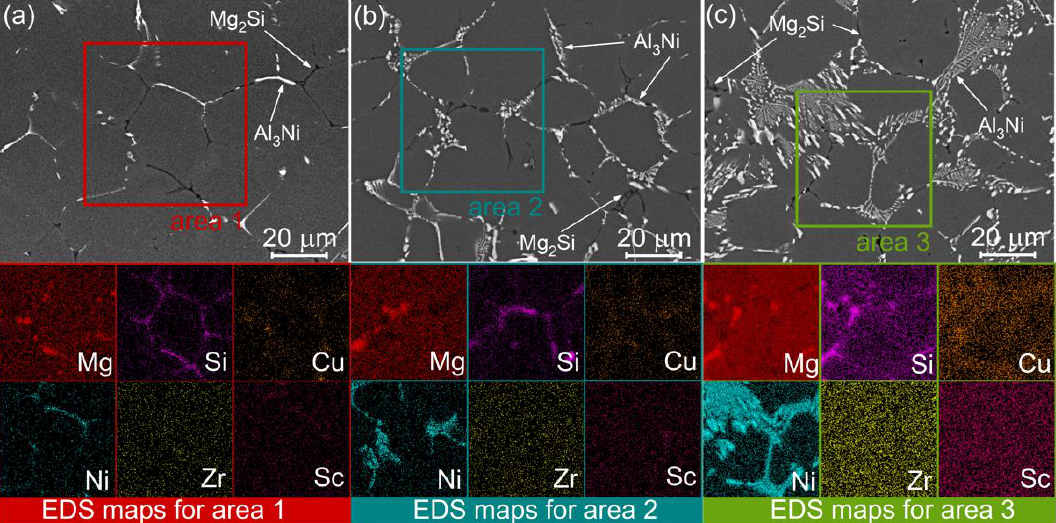
Figure 3. BSE images corresponding to SEM-EDS maps for the ( a ) alloy 1 (Al-1.2Mg-0.7Si-1.0Cu-0.5Ni), ( b ) alloy 2 (Al- 1.2Mg-0.7Si-1.0Cu-2Ni), and ( c ) the alloy 3 (Al-1.2Mg-0.7Si-1.0Cu-4Ni) in as-cast state.